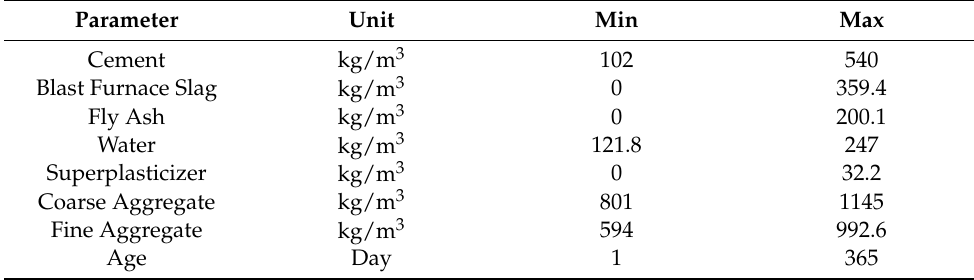
Table 1. Parameters of recycled concrete.